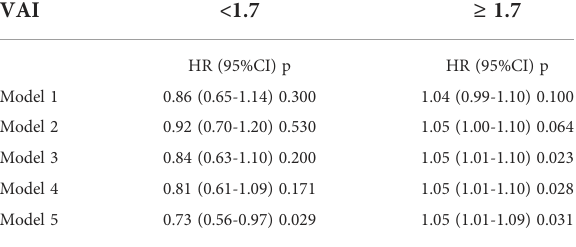
TABLE 2 Weighted associations between the VAI and all-cause mortality in the multivariable, and crude analyses. VAI <1.7